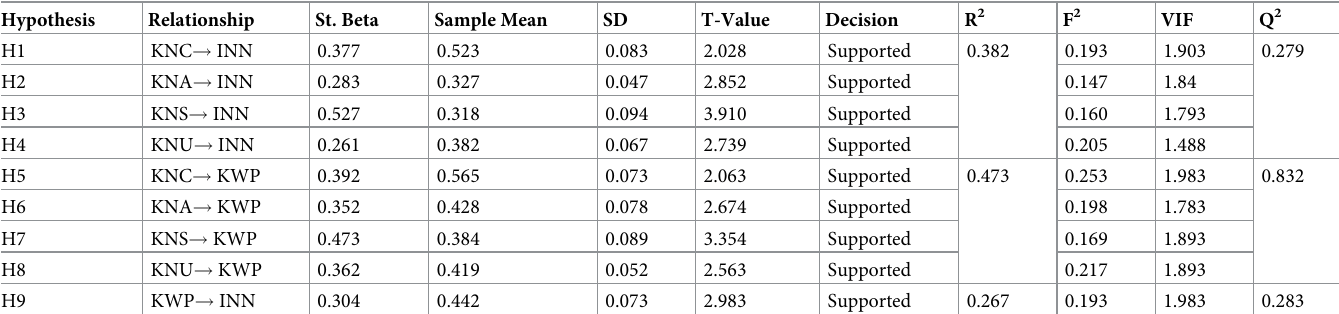
Table 5. Results of the structural model analysis (hypothesis testing).